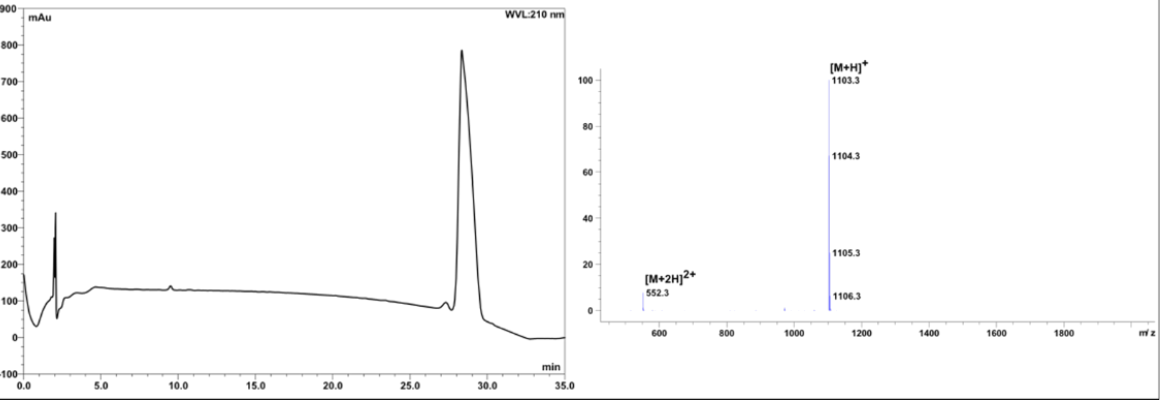
Figure 3. Analytical RP-HPLC profile of the simplified trichoderin A analogue ( 4 ) (>99% purity as judged by peak area at 210 nm); xTerra ® MS C18, 4.6 × 150 mm, 5 µm, linear gradient of 5% to 95% B (ca. 3% B min −1 ), flow rate 1 mL min −1 . ESI-MS m / z [M + H] + calculated: 1103.6; found: 1103.3.